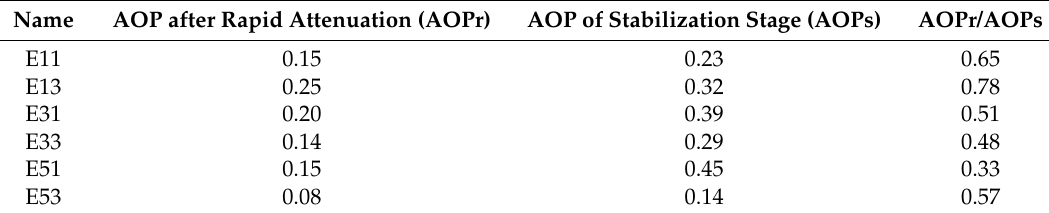
Table 1. The ratio of the attenuance of the lateral earth pressure (AOP) after rapid attenuation to the AOP of the stabilization stage.